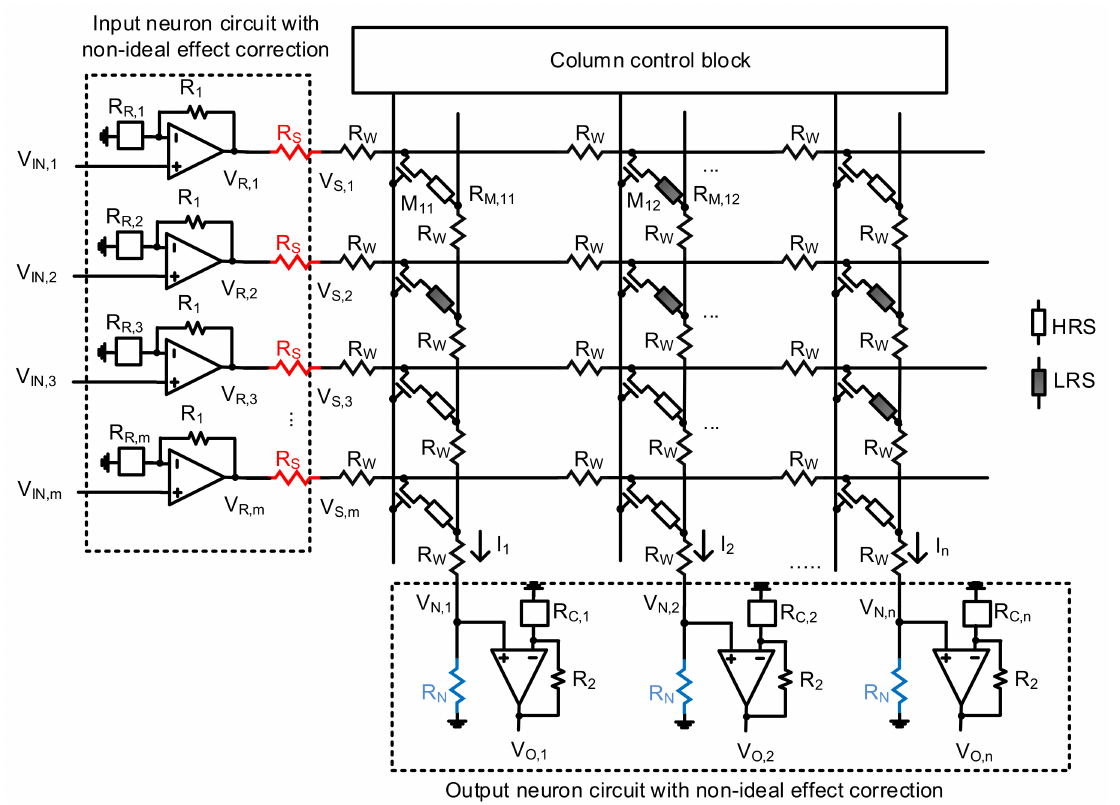
Figure 3. Schematic of the proposed memristor crossbar circuit with correction of nonideal effects. Here the nonideal-effect correction circuit in the left is for compensating the loss of source voltage. The correction circuit added to the bottom is for reducing the loss of output